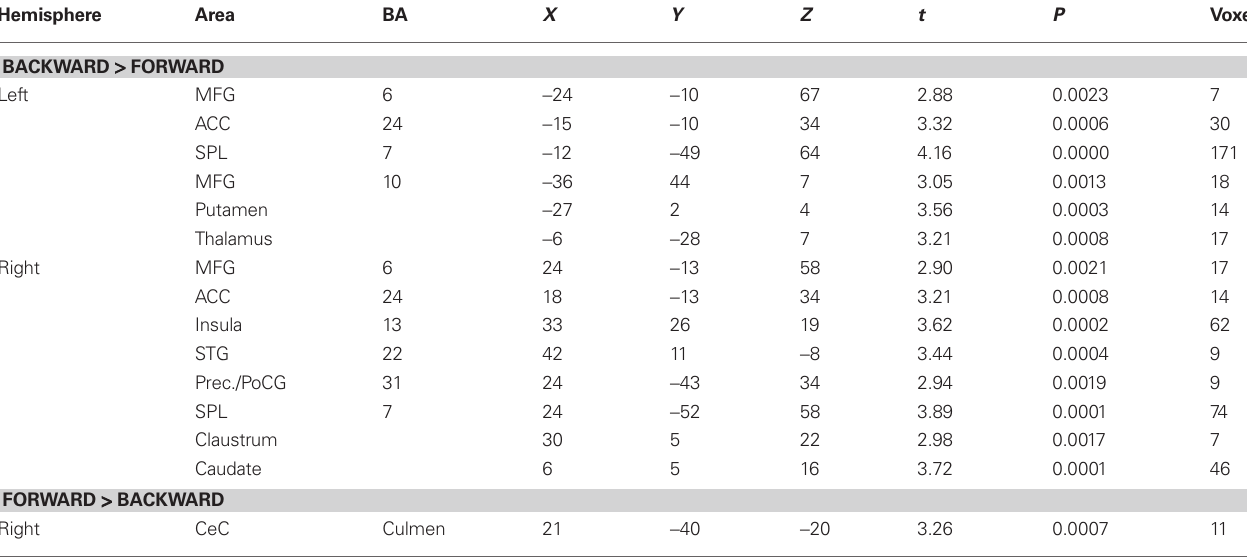
FoRwARD > BACKwARD Right CeC BA, Brodmann area; PrCG, precentral gyrus; SPL, superior parietal lobule; MFG, middle frontal gyrus; ACC, anterior cingulate cortex; STG, superior temporal gyrus; Prec., precuneus; PoCG, postcentral gyrus.